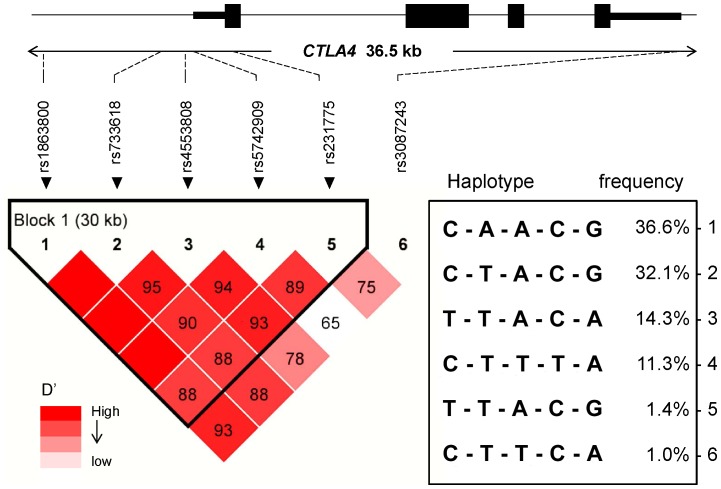
Haplotype block and LD test of candidate CTLA4 variants in 36.5 kb genomic region.Generated by Haploview (version 4.2), and each box represents the D′ valuebetween pairs of SNPs (ranging from 0 to 1). Dark red, strong LD; light red, weak LD.